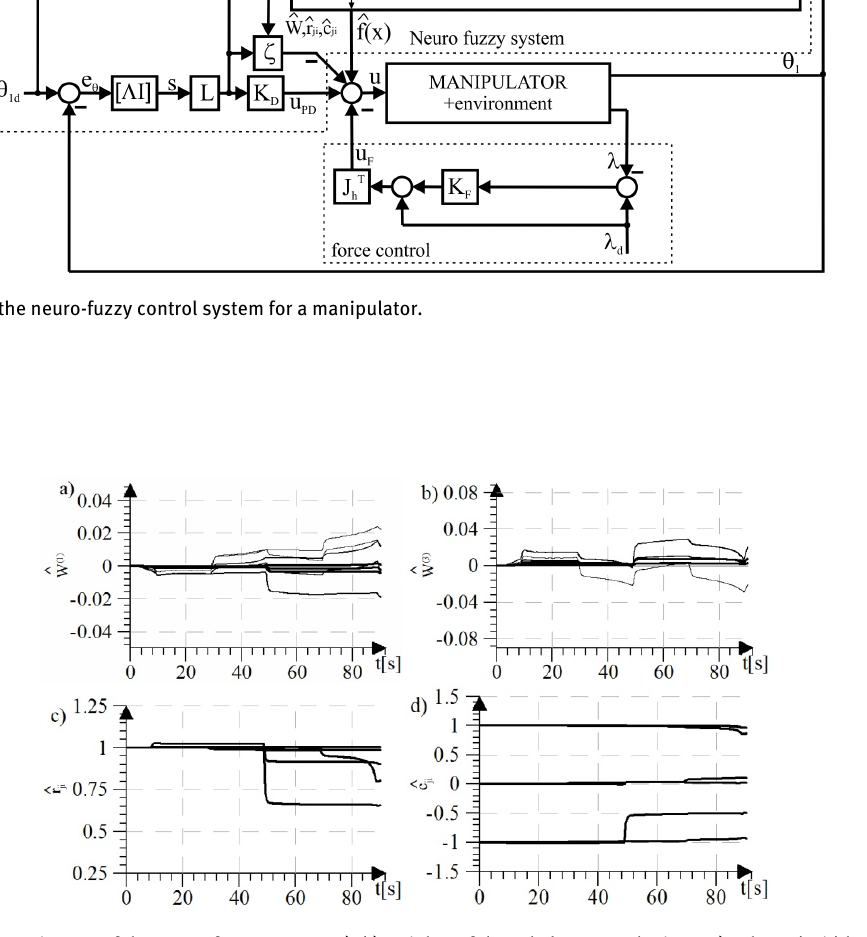
Figure 8: The parameter estimates of the neuro-fuzzy system: a), b) weights of the rule base conclusions, c) selected widths of the Gaussian functions, d) selected centers of the Gaussian functions.